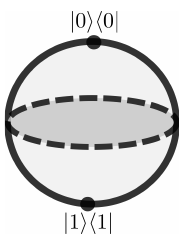
Figure 8: The state space of a quantum bit can be represented as a three-dimensional ball, the Bloch ball. The pure quantum states lie on the boundary (the sphere), with orthogonal states on antipodal points of the sphere. The center represents the mixed state 1 . In contrast to the classical states, convex decompositions of mixed states into pure states are not